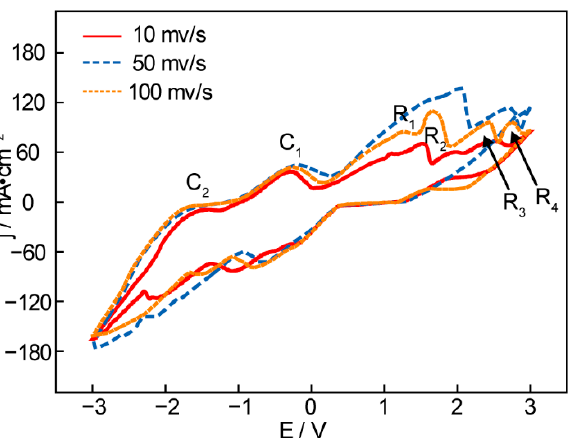
Figure 5. Cyclic voltammetry recorded from an Ni anode and Fe cathode in Li 1.43 Na 0.26 K 0.21 CO 3 + 0.15LiOH at 550 °C with different scanning rates.